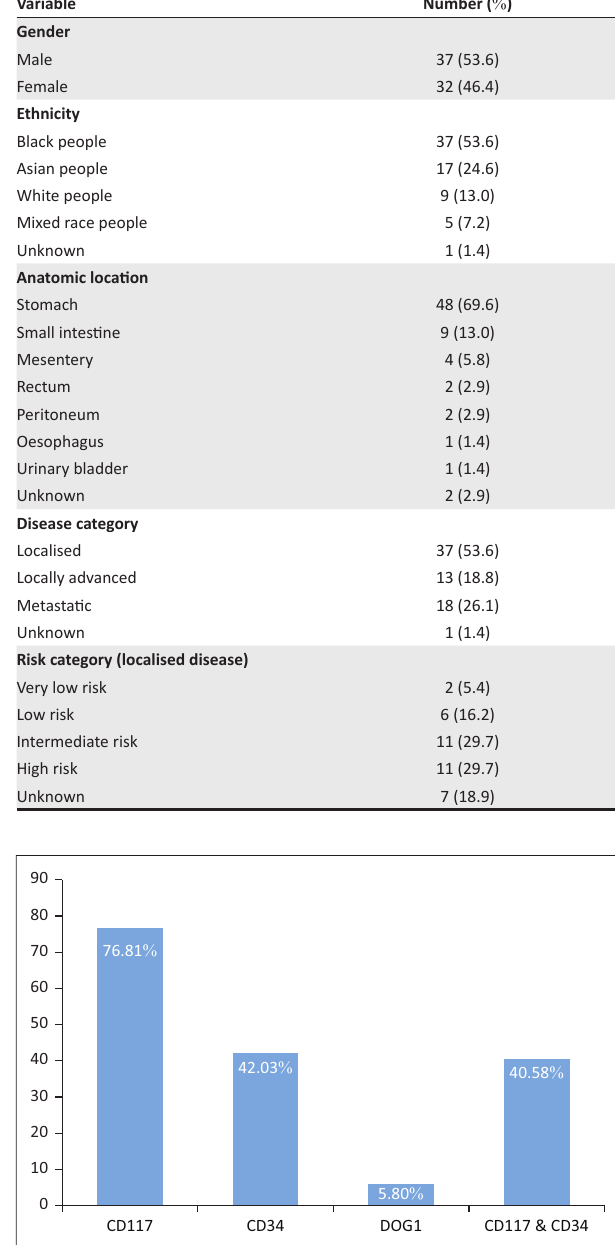
TABLE 1: Patient demographics and disease characteristics.